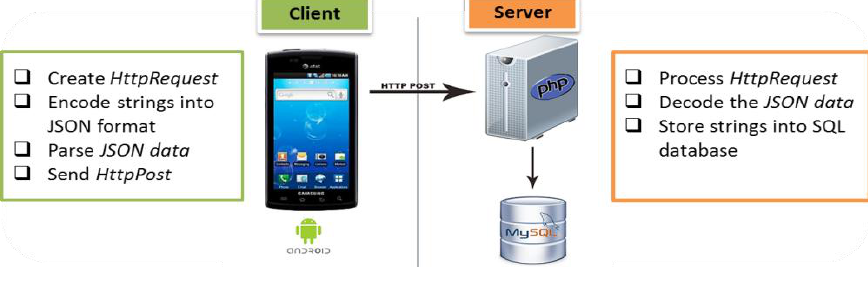
Figure 9. Client-server model. The clients request and receive service from the centralized